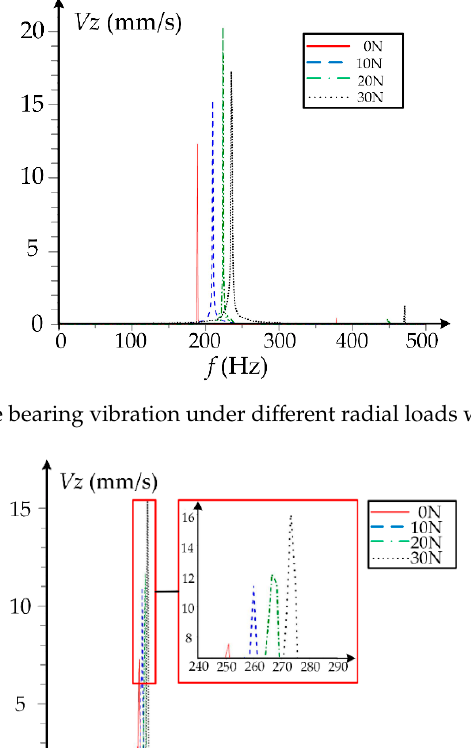
Figure 8. The bearing vibration under different radial loads when L = 1.5.